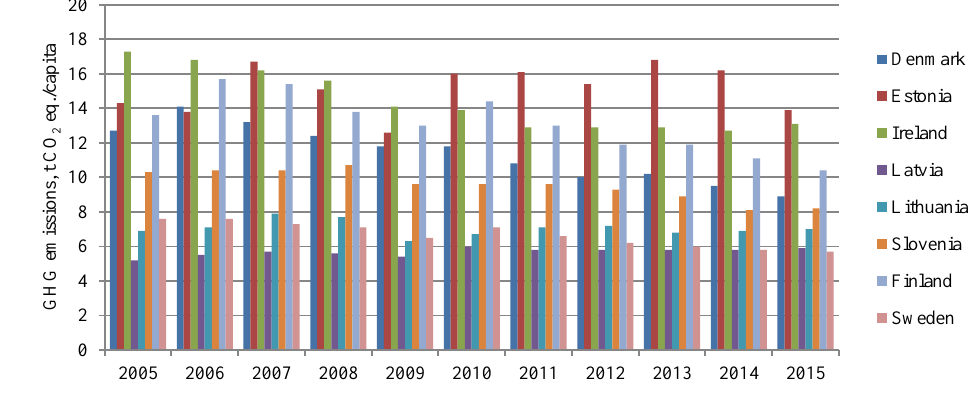
Fig. 1. GHG emissions per